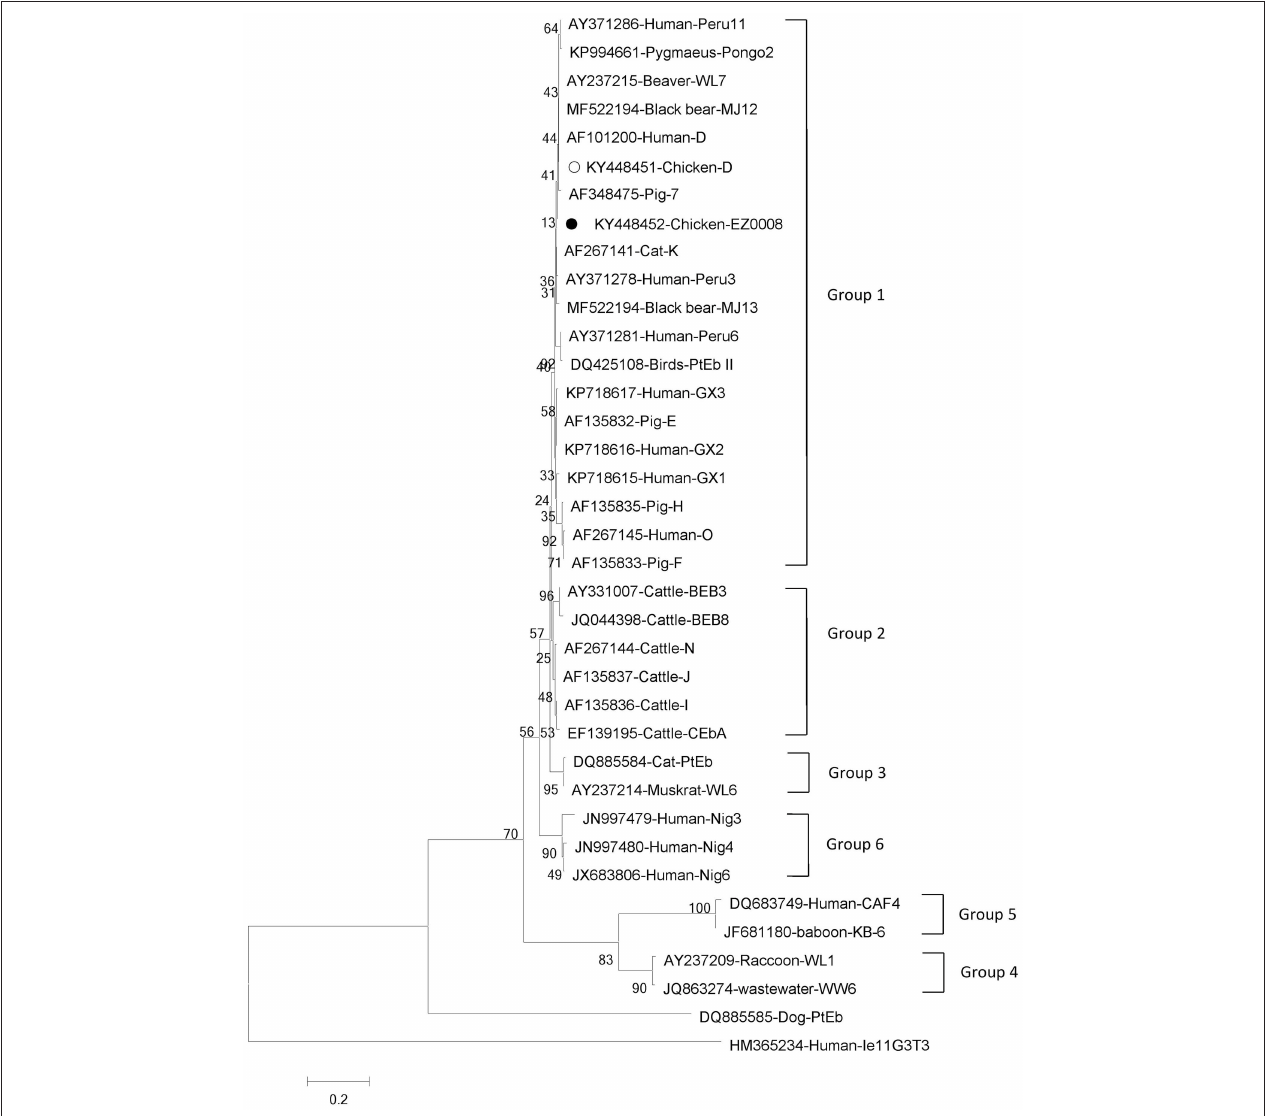
FIGURE 2 | Phylogenetic relationships between genotype groups of Enterocytozoon bieneusi . The relationships were inferred using neighbor-joining analysis of internal transcribed spacer (ITS) sequences based on genetic distance calculated by the Kimura two-parameter model. Each sequence is marked with its accession number, host origin and genotype designation. The numbers on the branches are percentage bootstrapping values from 1,000 replicates. Open and solid circles, respectively, indicate previously known and novel sequences identified in this